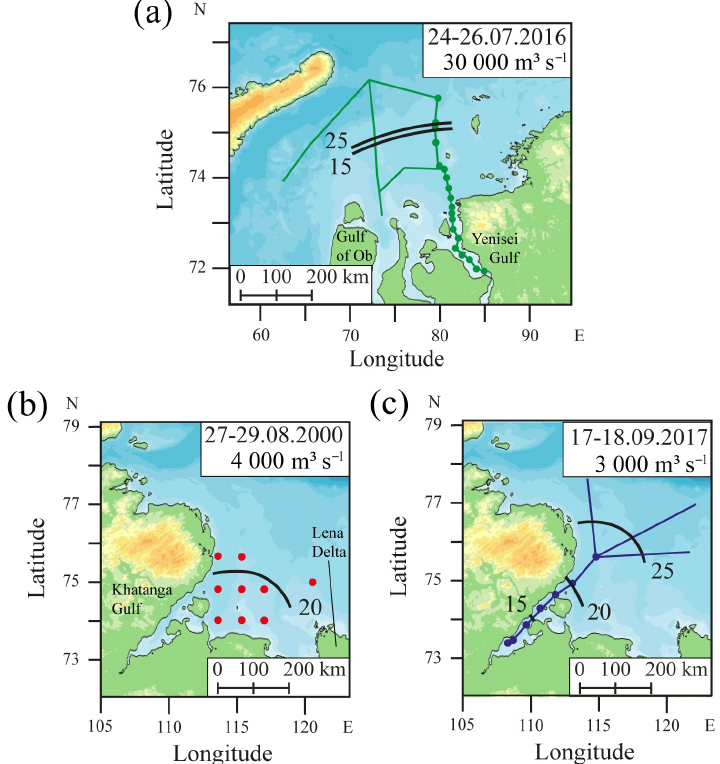
Figure 7. Location of the isohalines of 15, 20, and 25 at the surface layer (black lines) at the central part of the Kara Sea (a) and the western part of the Laptev Sea (b, c) indicating spatial scales of the Ob–Yenisei (a) and Khatanga (b, c) river plumes reconstructed from in situ measurements conducted in August 2000 (red) and September 2017 (blue) in the Laptev Sea and in July 2016 (green) in the Kara Sea. The dates of the field measurements and the discharge rates of the rivers during these periods are shown at the figures. The graphic scales correspond to the latitude of 73 ◦